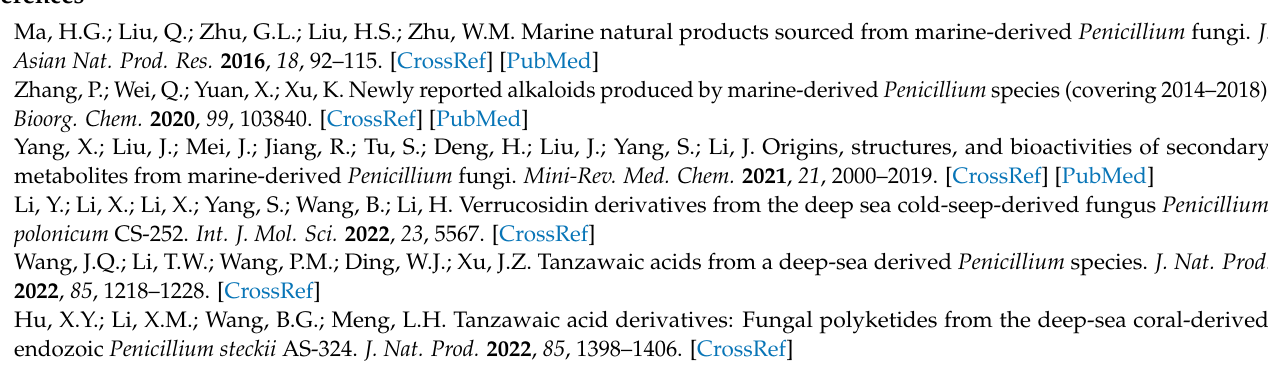
Figure S83: HRESIMS spectrum of 11 R ,14 E -(+)-penilloid A ( 3